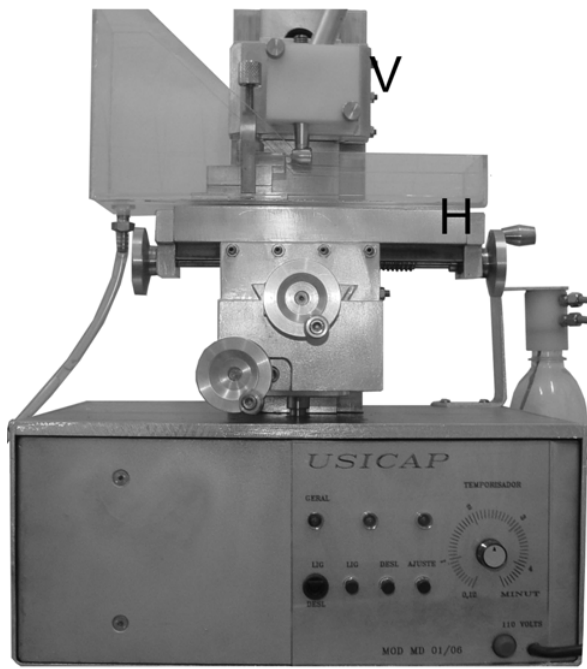
FIGURE 2- Cutting machine: V - Vertical platform; H -